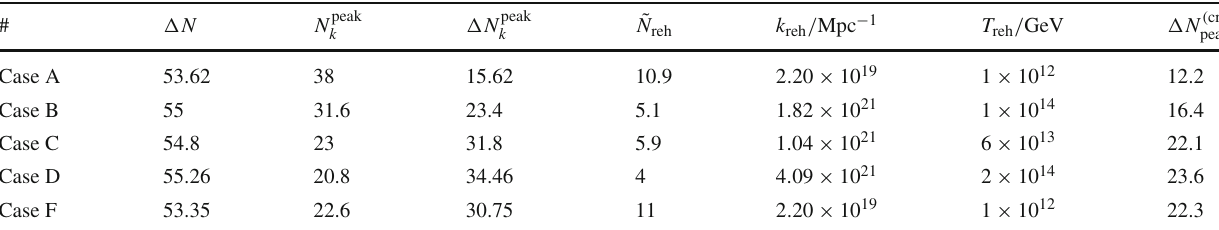
Fig. 4 Evolution of the scalar power spectrum as a function of k for Case A (purple line), Case B (green line), Case C (red line), Case D (blue line), and Case F (brown line). The shadowy zones represent the re-entered scales to the horizon during the reheating stage Table 3 The values of N peak